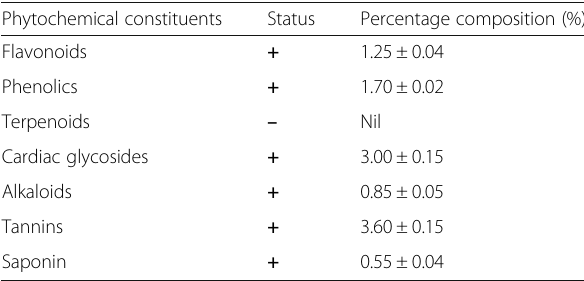
Table 3 Qualitative and quantitative determination of phytochemicals in